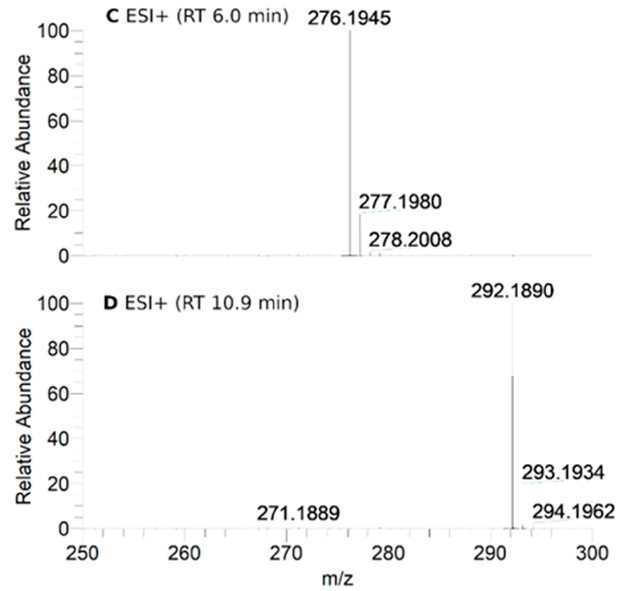
Figure 3. HPLC-HRMS study of nitroxide 5 (300 µ M) incubated with RLM (7.8 mg · mL − 1